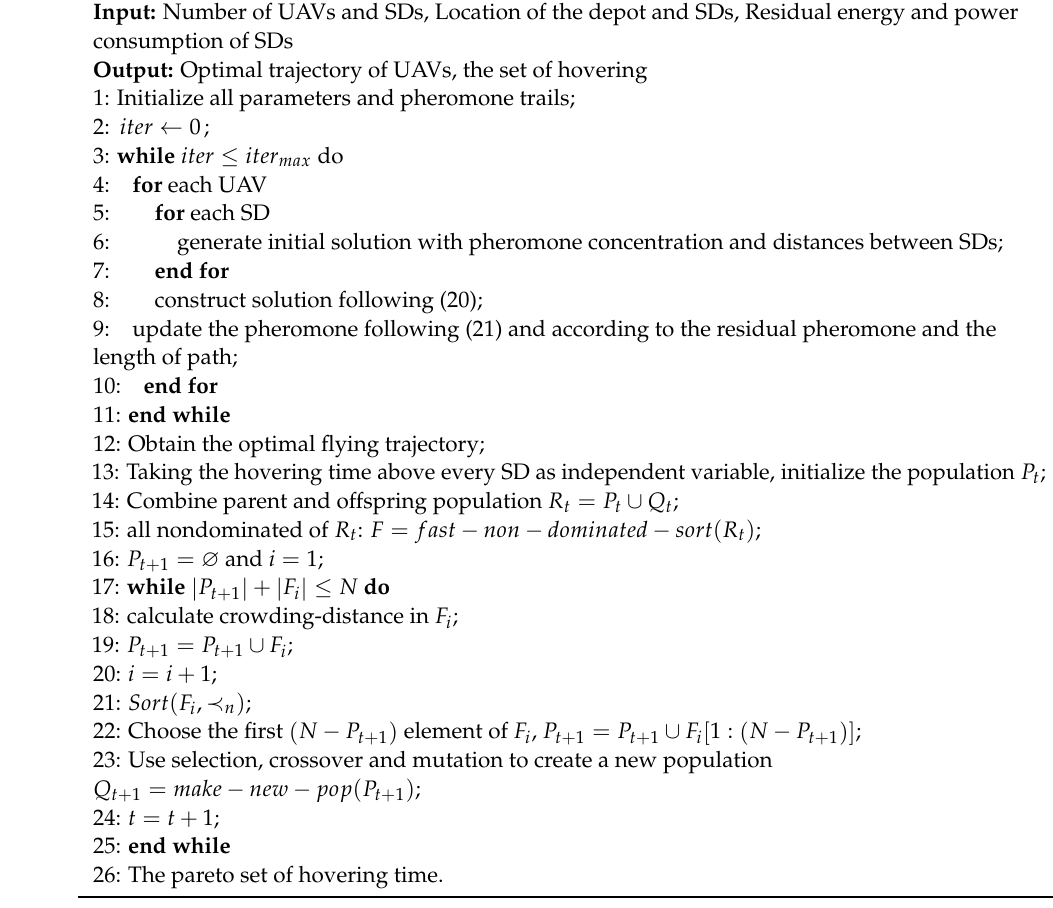
Algorithm 1 Pseudo-code of the multiple ant colony-nondominated sorting genetic algorithm